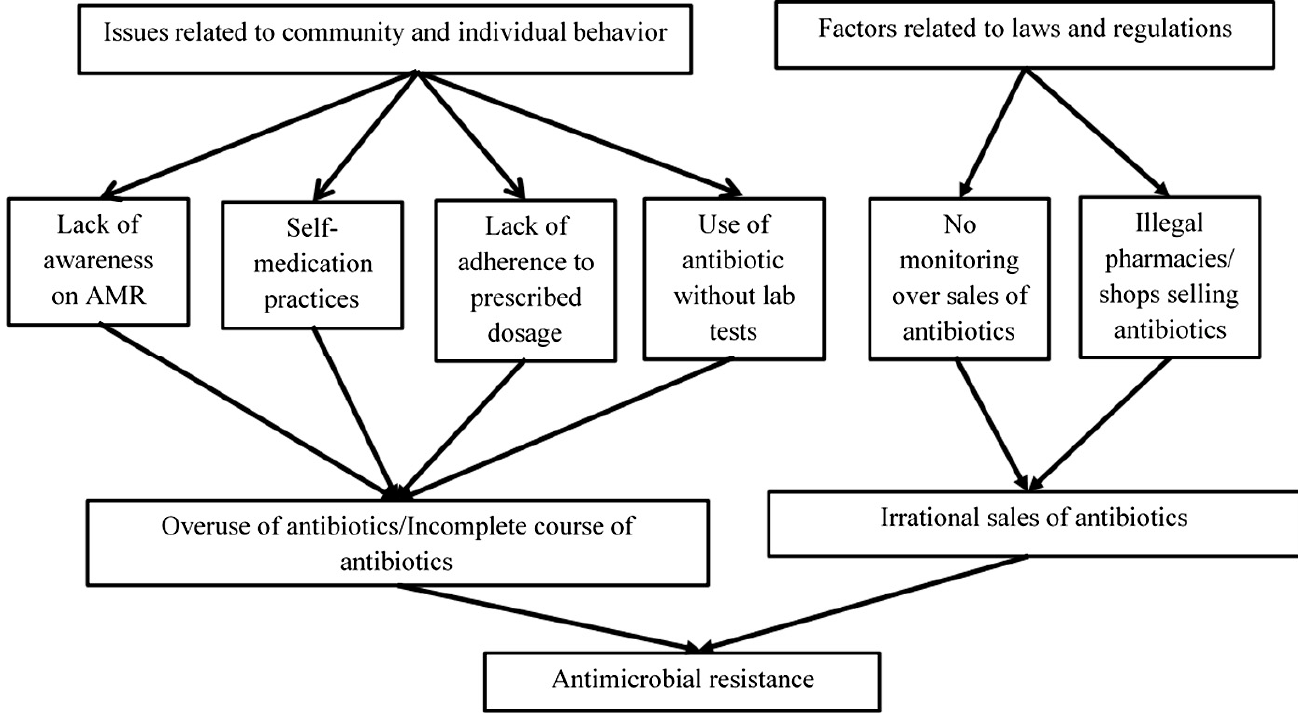
Figure 2. Local drivers of AMR as perceived by ward chairpersons, policy makers, pharmacists, community members, and health in-charges in Dhulikhel municipality, 2021.